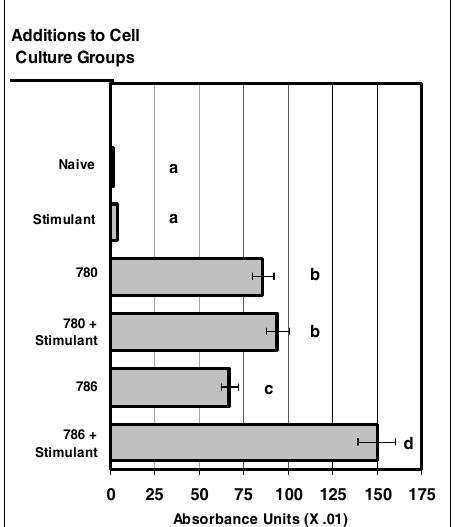
Figure 2: NIR micro-sensor dyes are internalized neutrophils. Neutrophil cultures were treated with either vehicle or NIR-spectra micro-sensor dyes (NIR-786 or NIR-780; 20 µg/10 6 cells, respectively) and incubated for 24 hours. After this incubation period, neutrophil cultures were stimulated with LPS for 24 hours. After the 24-hour stimulation period, neutrophil cultures were analyzed for micro-sensor dye uptake. Spectral absorptivity was used as the endpoint for indicating cellular uptake. Percent values are expressed as the mean + SEM, N = 8. Statistical significance (a), (b), (c), and (d) were expressed as P < 0.05 in comparison to each other.